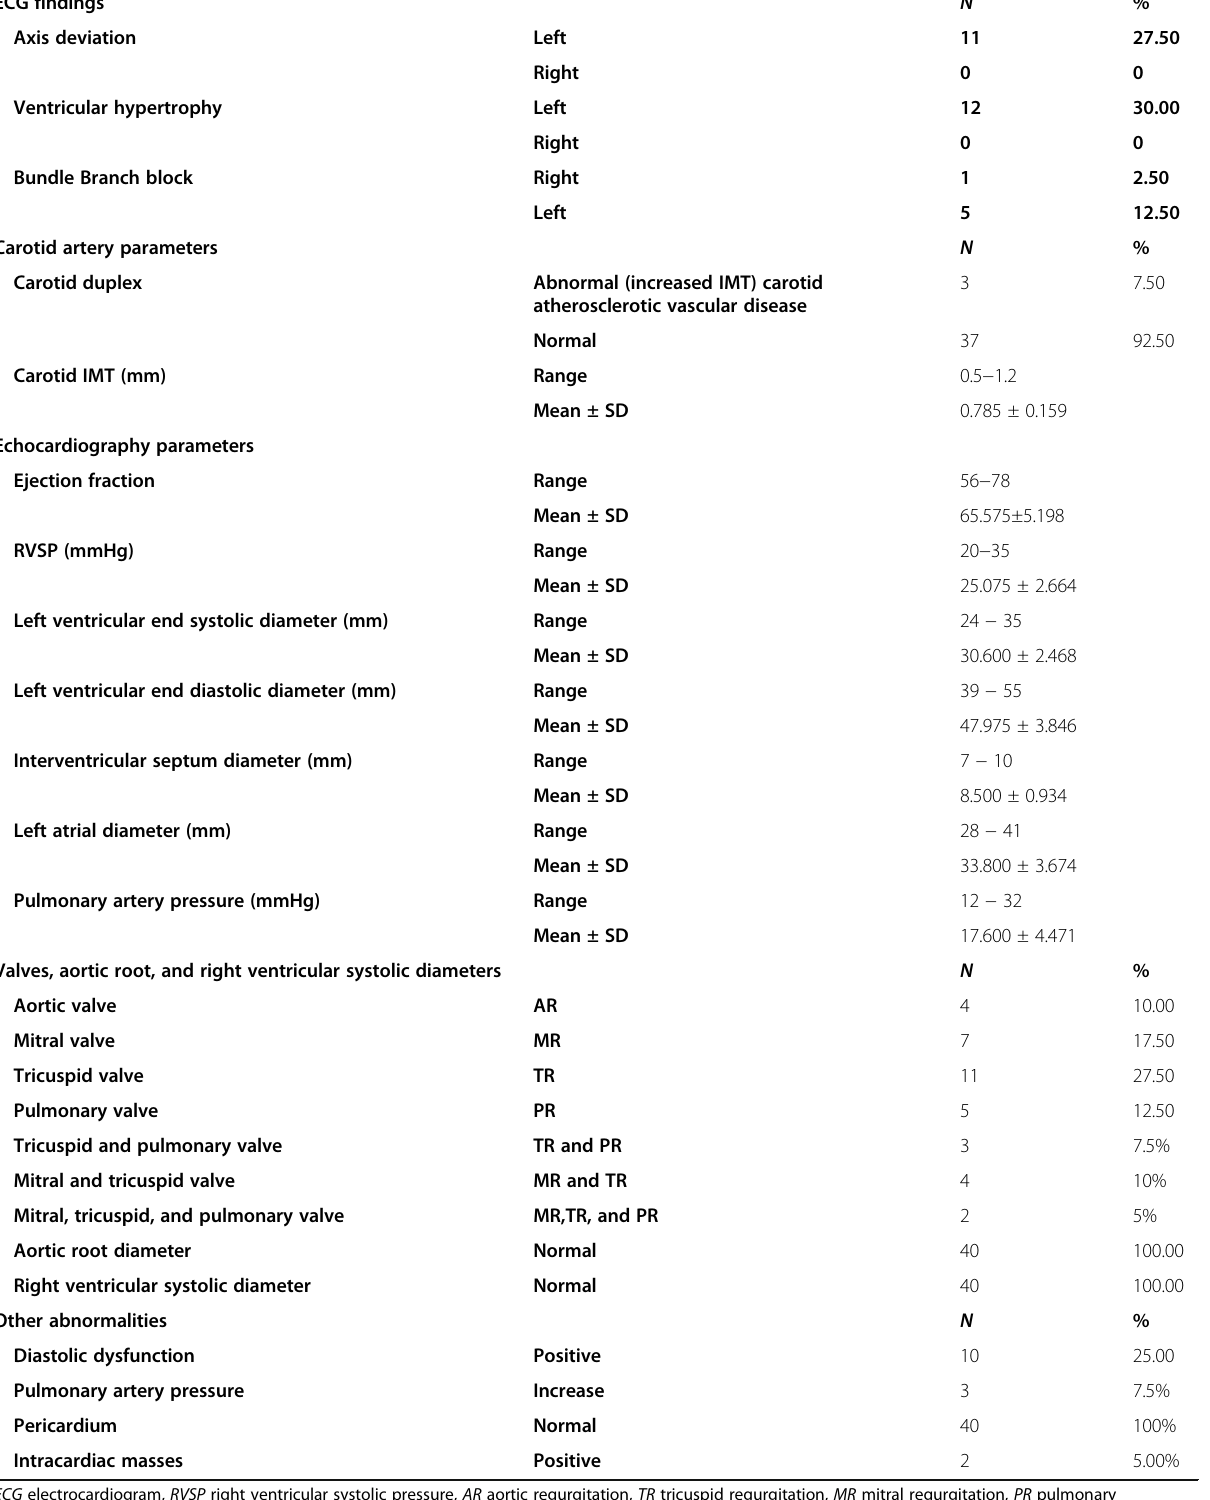
Table 2 Findings of ECG, carotid Doppler, and echocardiography among included Behçet ’ s patients ( N =